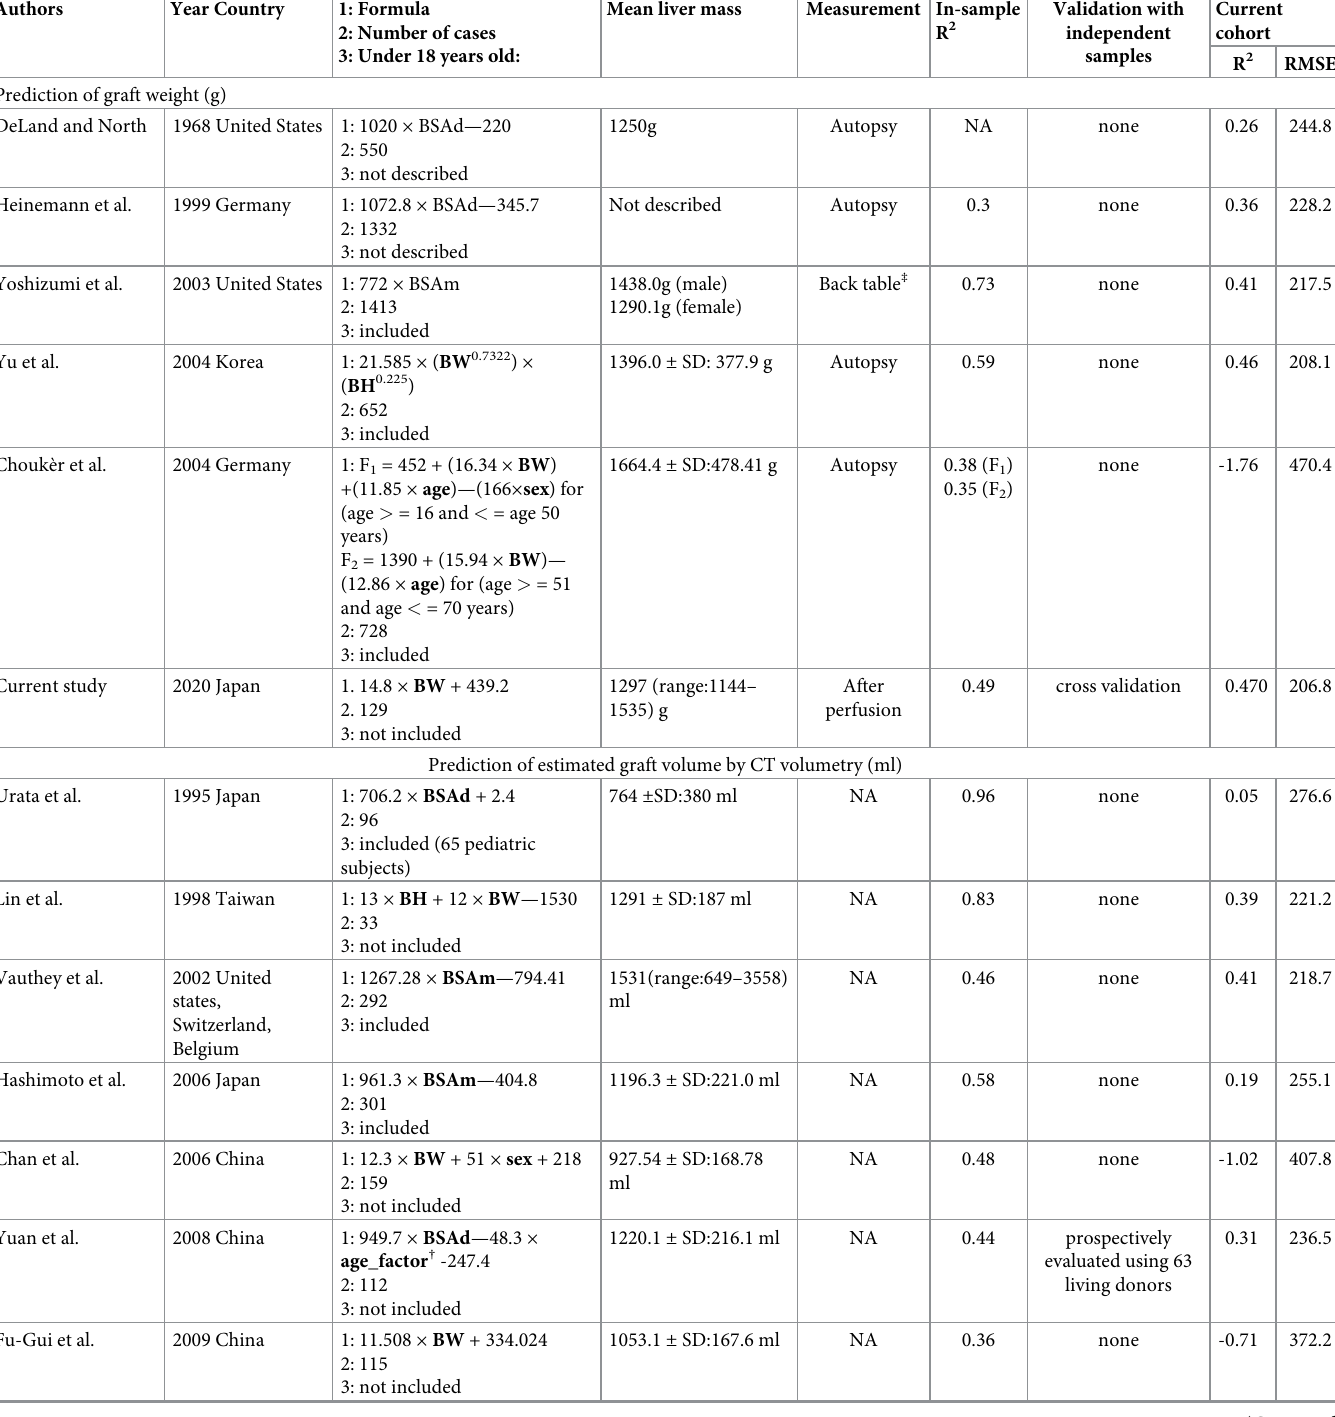
Table 1. Previously reported estimation formulas for whole liver weight or volume and their fit to the current